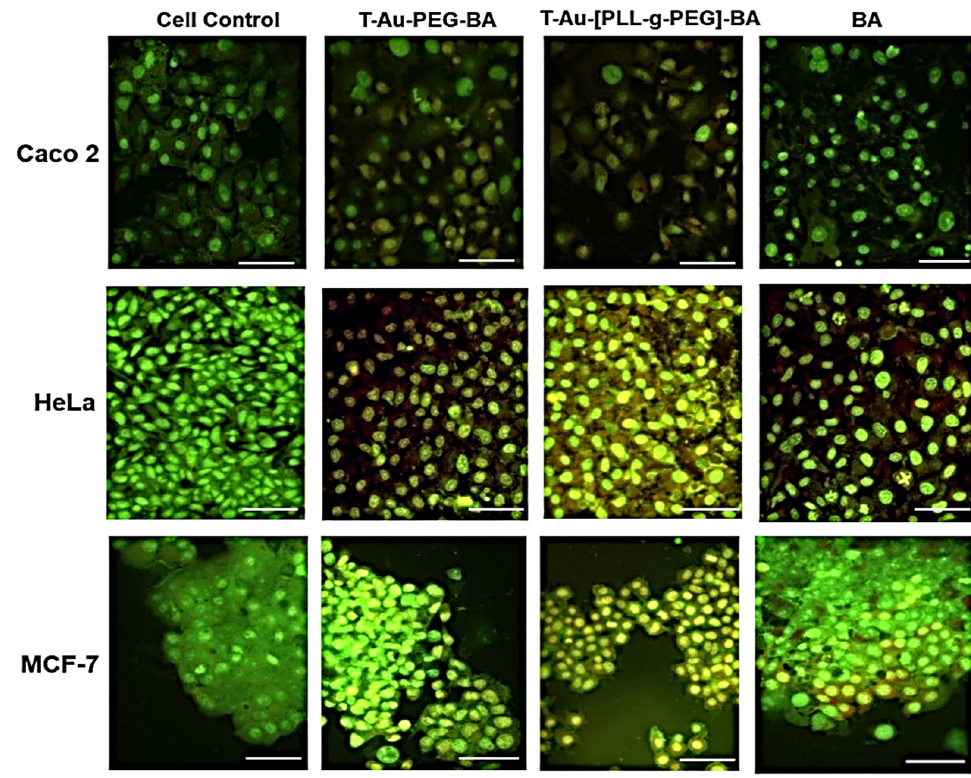
Figure 12. Sectional fluorescent images of acridine orange/ethidium bromide stained cells showing apoptosis induction by targeted nanocomplexes. T-Au-PEG-BA; T-Au-[PLL-g-PEG]-BA = targeted nanocomplexes, and BA = free drug. Untreated cells and BA served as controls. Scale bar = 100 µm.